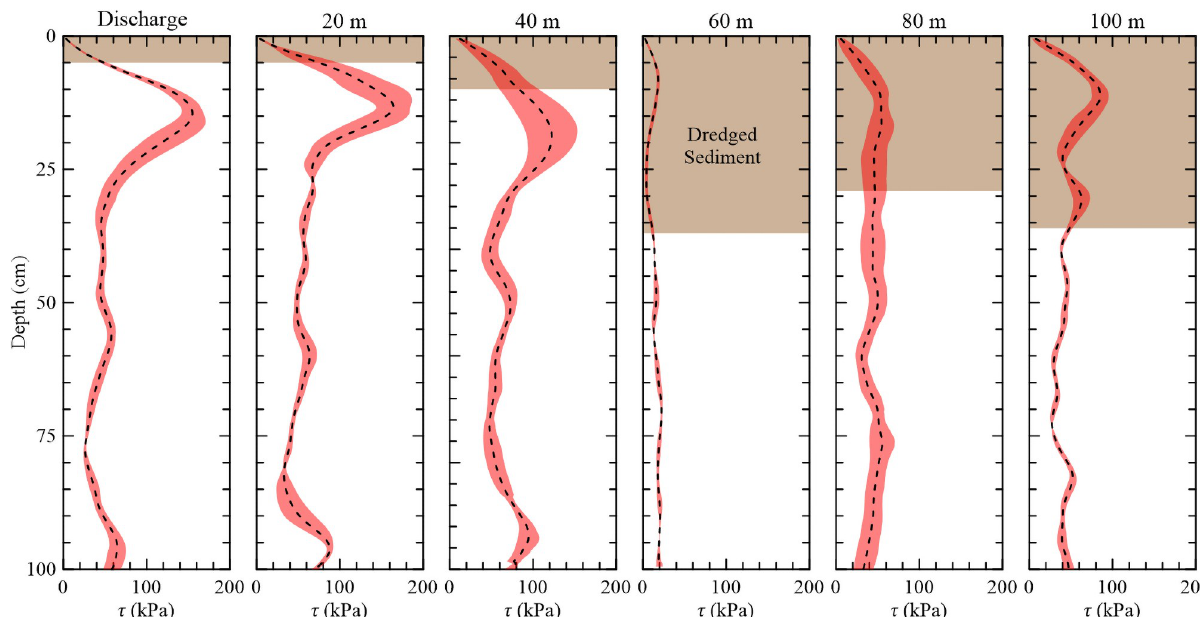
Fig 6. Average shear strength and dredged sediment depths along Transect A moving away from the discharge. Shaded regions represent ± 1 SD.